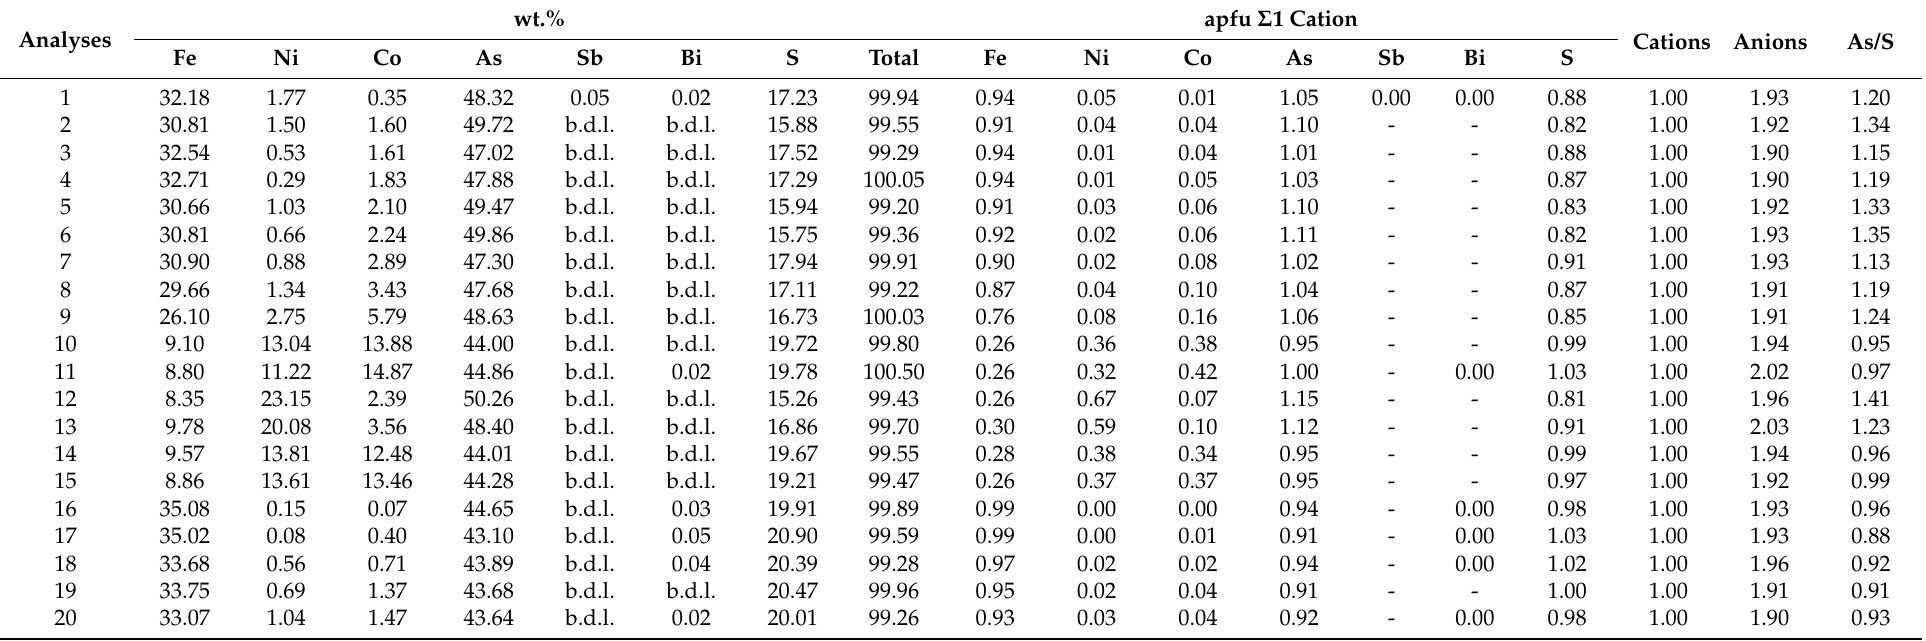
Table 10. Representative EPMA data for sulfarsenides: early arsenopyrite (Apy1) [1–9], cobaltite [10,11], gersdorffite [12–15], and younger arsenopyrite (Apy2) [16–20] from the Kizhnica hornfels, b.d.l. = below detection